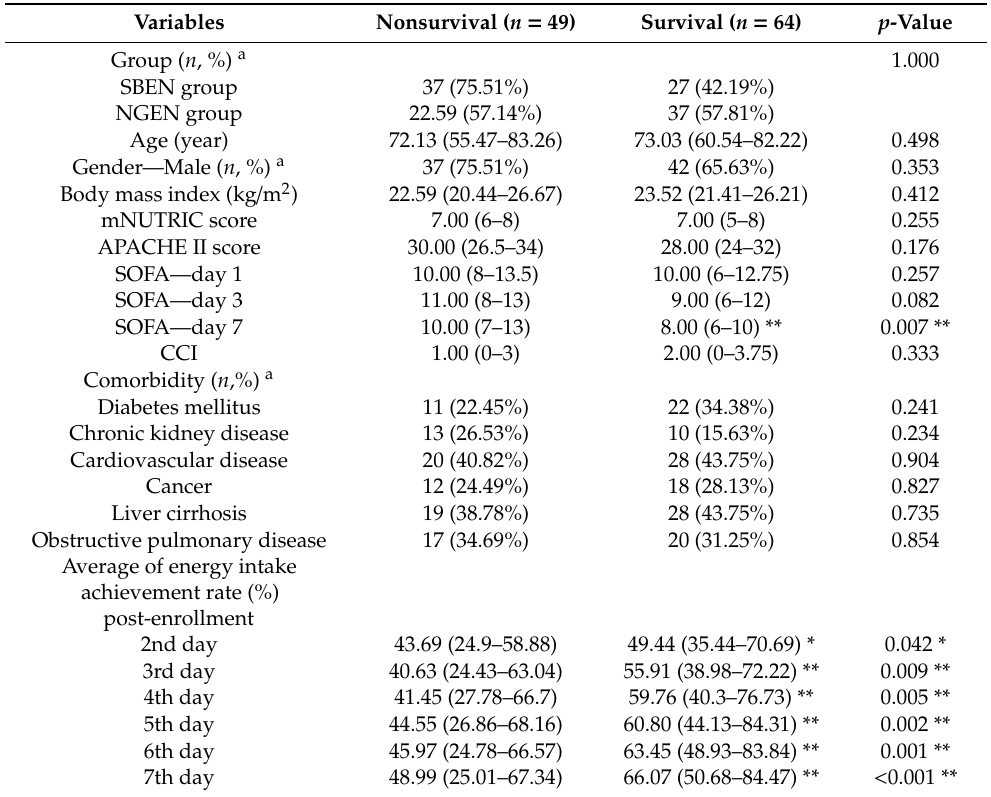
Table 3. Comparison of survivors and nonsurvivors according to hospital mortality in malnourished, critically ill, ICU patients.